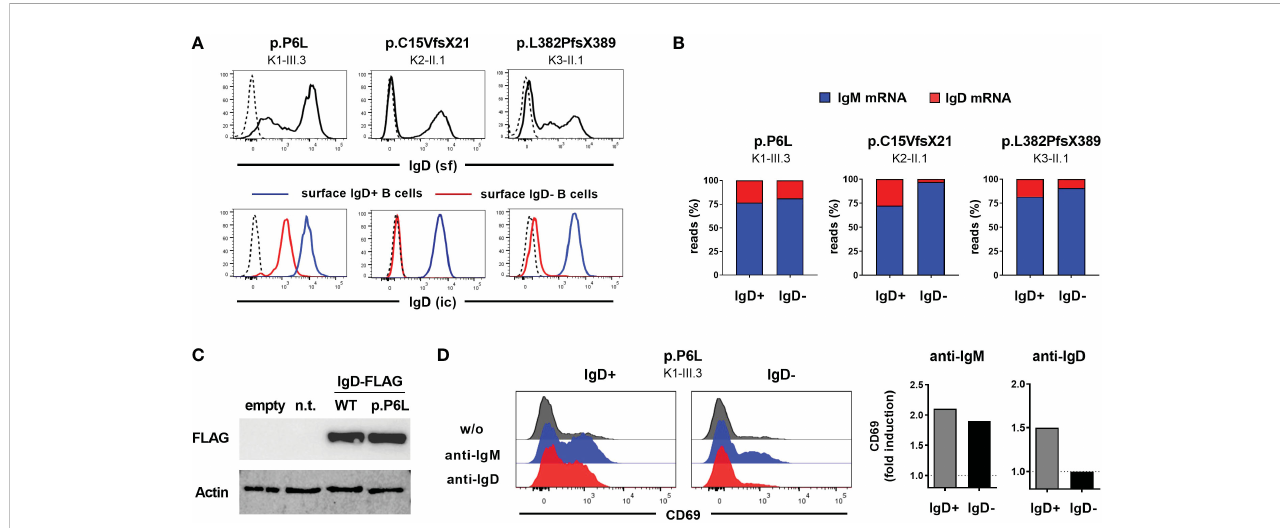
FIGURE 2 Characterization of IGHD variants reveal loss-of-expression or loss-of-function (A) Flow cytometric analysis of surface IgD expression on CD19 + CD27 - IgM + naïve B cells from 3 individuals carrying different heterozygous IGHD variants (upper row). Intracellular IgD expression within surface IgD+ (blue line) or surface IgD- (red line) CD19 + CD27 - IgM + naïve B cells from the same individuals (lower row). Dashed lines represent isotype controls. (B) Proportion of unique IgM or IgD sequence reads assessed by RNA-based IgH high-throughput sequencing within sorted CD19 + CD27 - IgM + CD10 - IgD + or IgD - mature naïve B cells from 3 individuals carrying different heterozygous IGHD variants (C) Immunoblot analysis of IgD Expression in 293T cells not transfected (n.t.) or transfected with an empty vector or an IgD-FLAG expression vector with wild type IgD sequence or the p.P6L variant. (D) Histograms showing fl ow cytometric analysis of CD69 expression on sorted IgD+ or IgD- CD19+CD27-IgM+ naïve B cells from an individual carrying the p.P6L IGHD variant stimulated in vitro with anti-IgM or anti-IgD for 48 hours. Fold induction (stimulated versus non-stimulated) of CD69 expression is shown on the